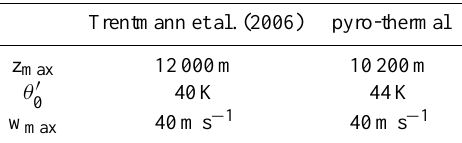
Table 1. Comparison of plume characteristics (injection height, virtual potential temperature excess, maximum vertical velocity) Fig. 4. Plume characteristics above the Chisholm fire: virtual potential temperature excess (K), vertical as obtained with the ATHAM high resolution model in Trentmann velocity (m s − 1 ) and cloudy liquid water (g kg − 1 ). et al. (2006) and with the pyro-thermal plume model. Trentmann et al.